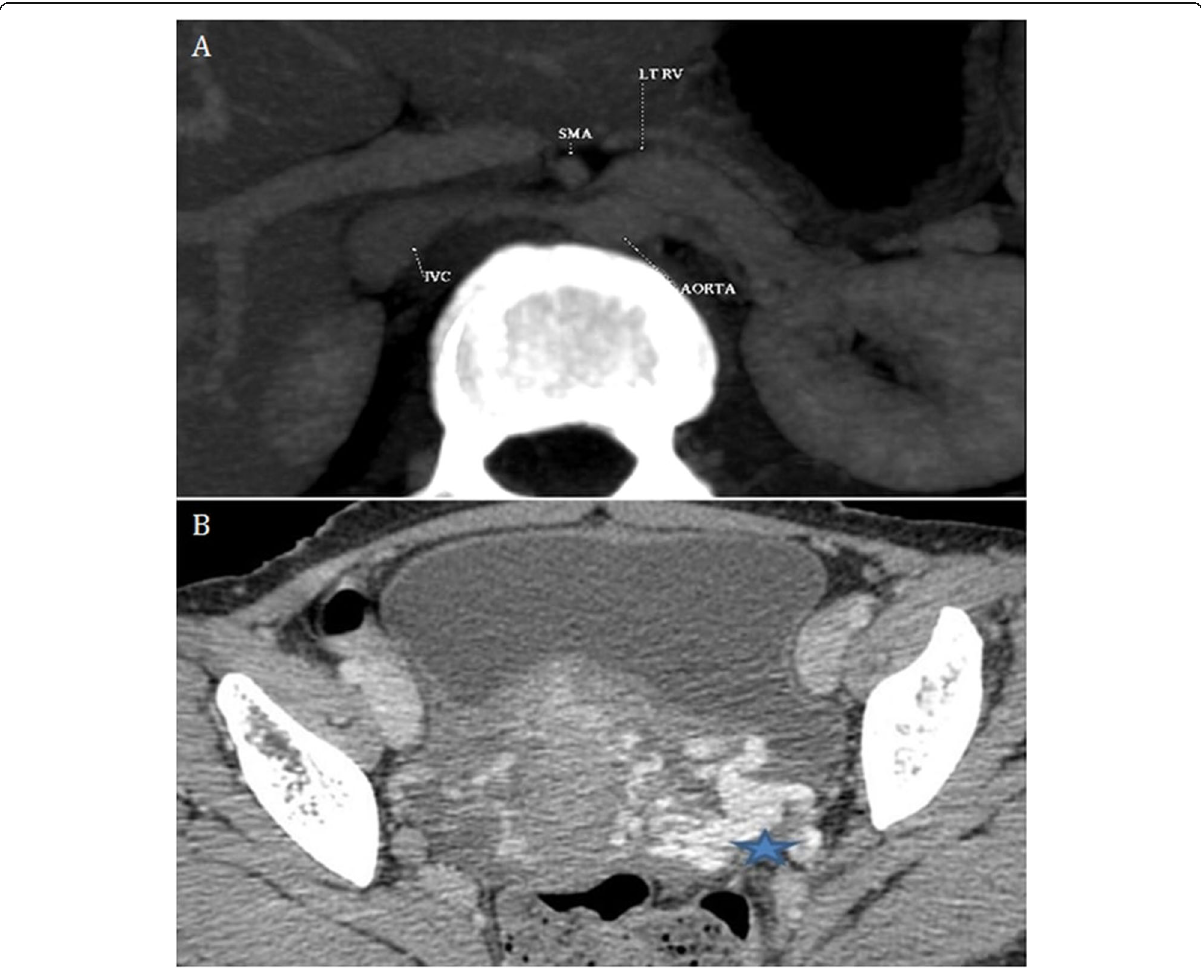
Fig. 7 Same case as in Fig. 6 with nutcracker syndrome. Reformatted axial MIP image ( a ) clearly depicts the compressed left renal vein between the SMA and the aorta. The axial section at the level of pelvis ( b ) shows the dilated and tortuous left gonadal